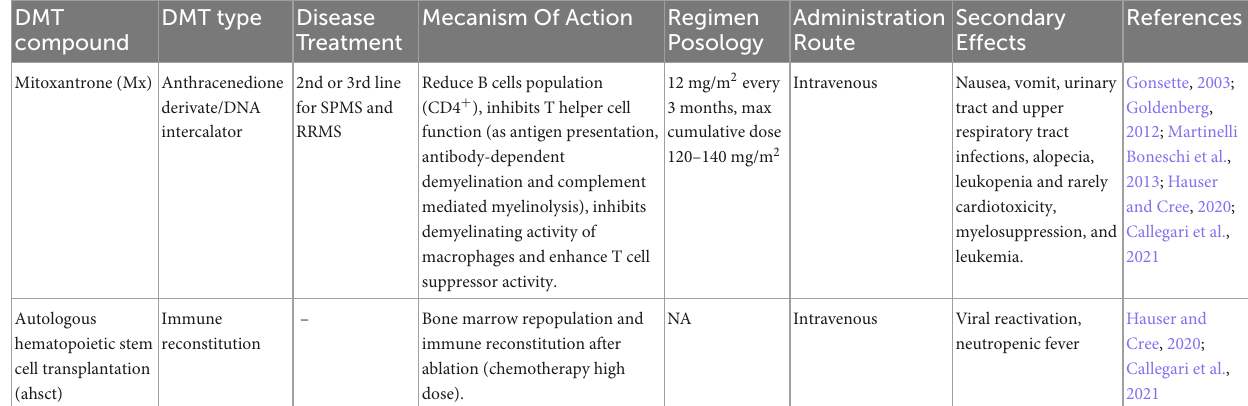
TABLE 6 Third line